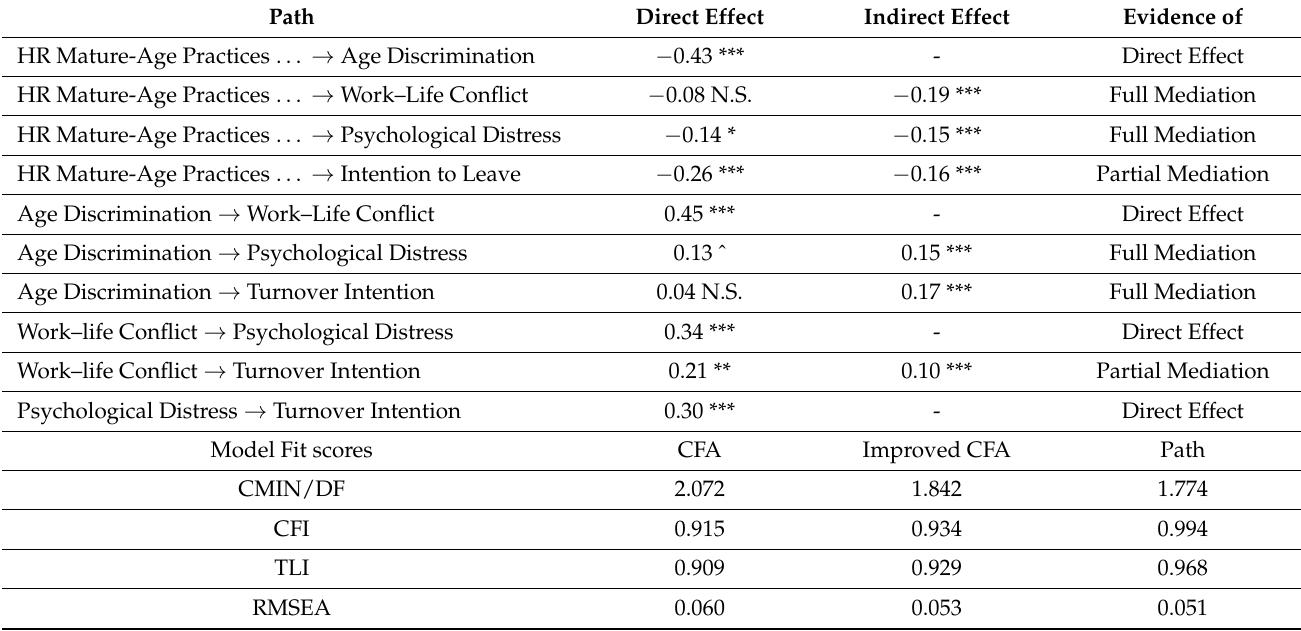
Table 4. Direct and Indirect Results from Path